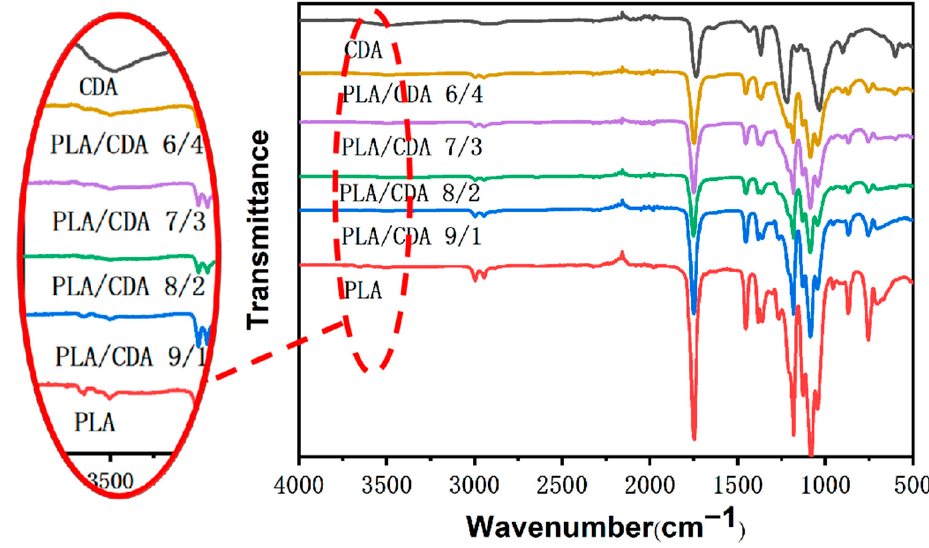
Figure 5. FTIR diagram of pure PLA, pure CDA, and PLA/CDA mixture fiber membranes.